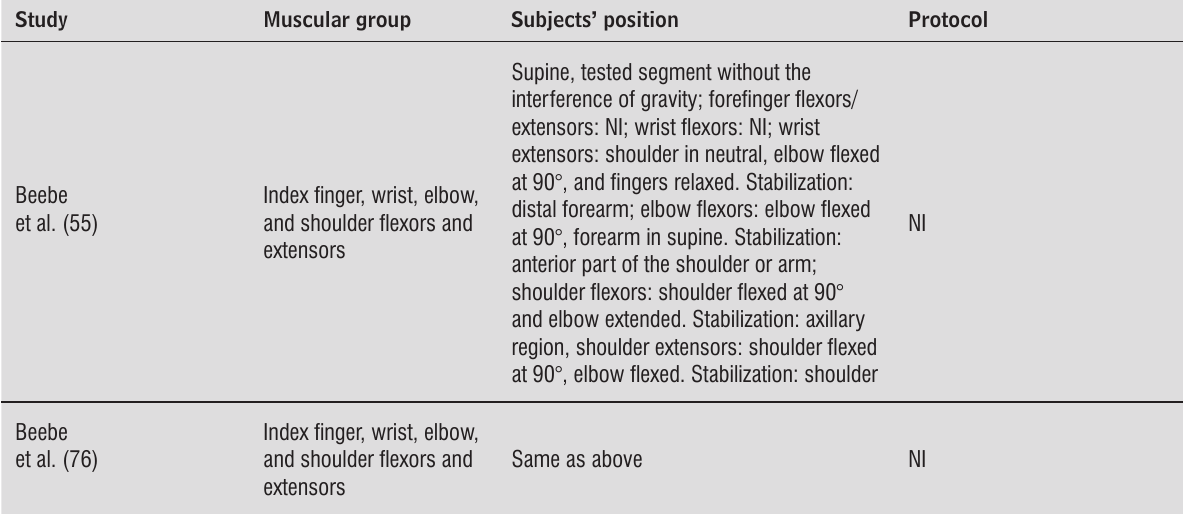
Table 4 - Data extraction of the 14 studies which assessed the upper limb strength in subjects with stroke with portable dynamometers and provided information regarding the subject’s positioning or the data collection protocol